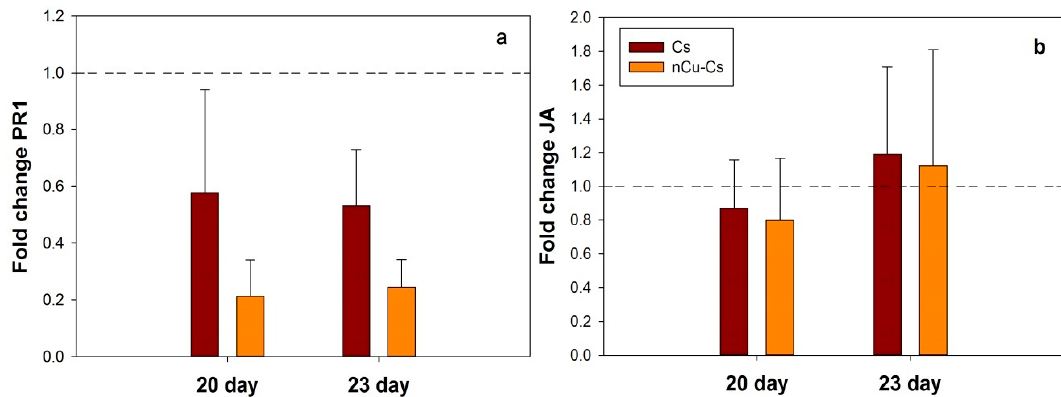
Figure 2. Expression of PR1 ( a ) and jasmonic acid (JA) ( b ) genes in tomato leaves at 20 and 23 days after transplant. Cs = 1 g Cs-PVA hydrogel; nCu-Cs = Cs-PVA + 10 mg Cu NPs. The data represent the mean ± standard error and the reference line represents the constant value of the absolute control.